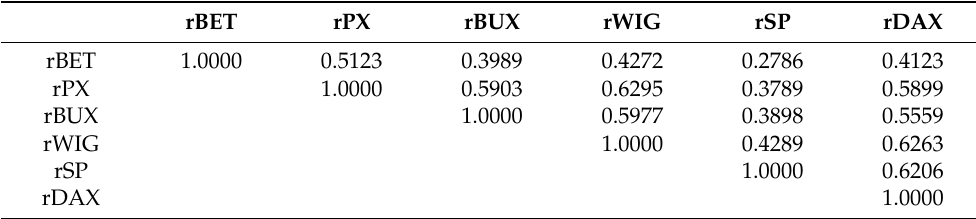
Table A2. The Correlation Coefficients of Daily Stock Returns.